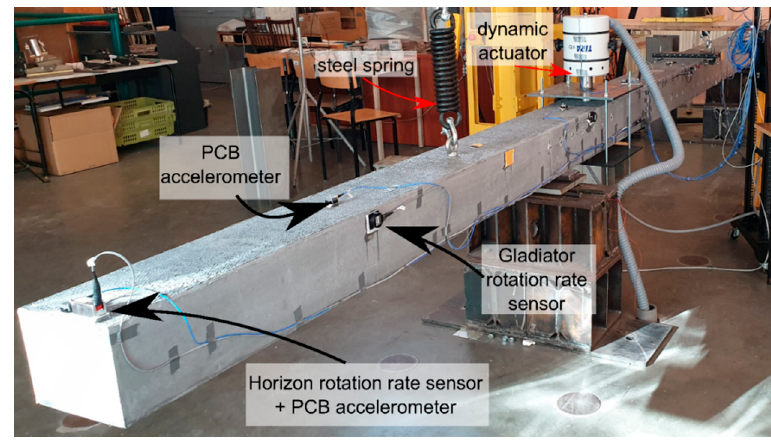
Figure 4. Experimental set-up for the tested beams.